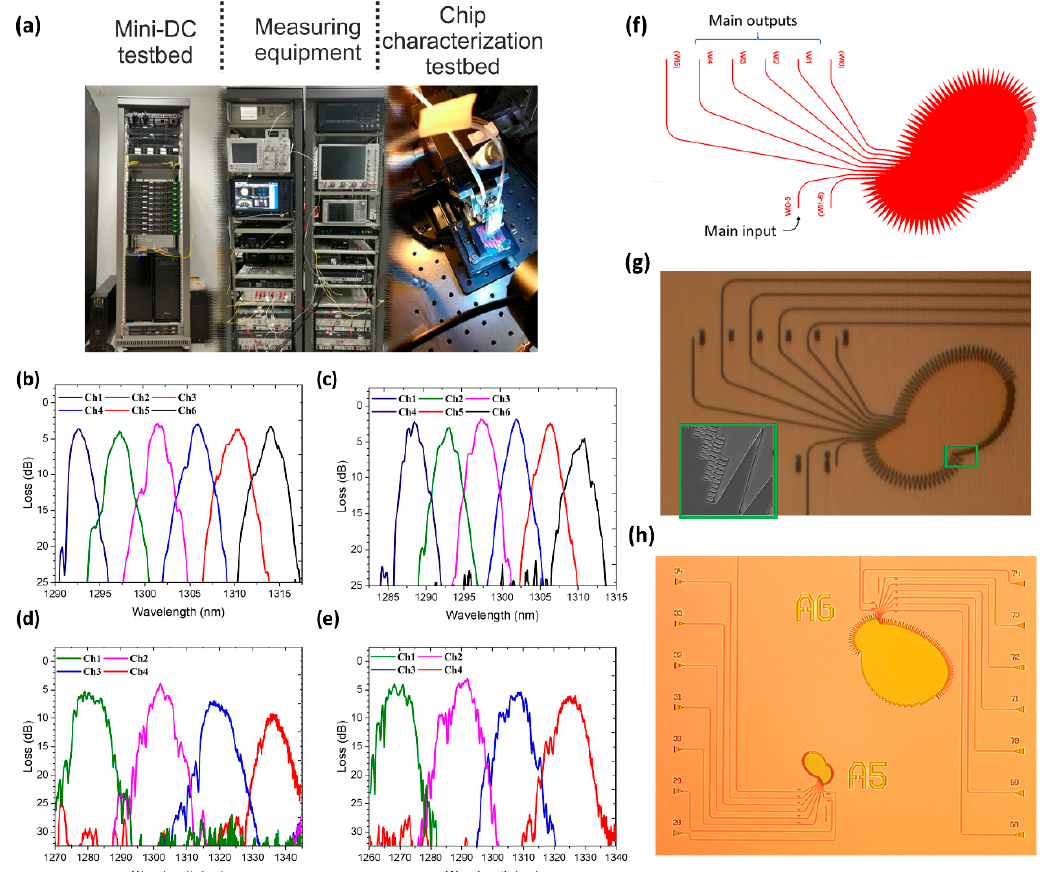
Figure 12. ( a ) The experimental testbed developed to interface with the L3MATRIX technology. ( b – e ) The experimental channel response of ( b ) input #1 and ( c ) input #2 of the 2 × 6 Echelle grating, followed by the response of ( d ) input #1 and ( e ) input #2 of the 2 × 4 configurations, respectively. The layout of the Echelle grating is shown in ( f ), where the diffractive grating is visible on the right side of the free space area. The sharp spikes reduce spurious reflections and so help to minimize the crosstalk. ( g , h ) Optical micrographs of the L3MATRIX Echelle gratings; inset of ( g ) shows an SEM image of the region indicated by the green rectangle.